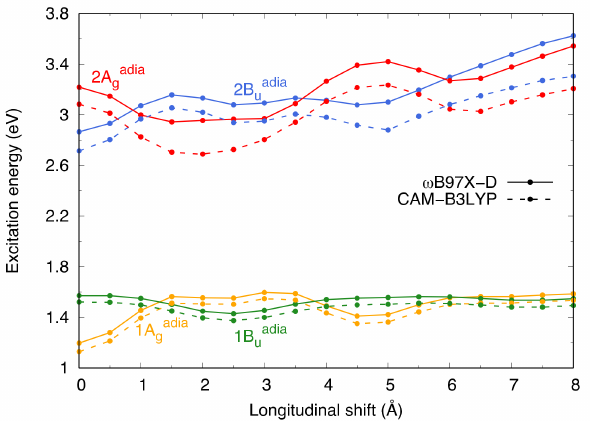
Figure 7. Comparison between excitation energies of triplet exciton states of PDI dimer computed with TDA-CAM-B3LYP/6-31G* (dashed) and TDA- ω B97X-D/6-31G* (solid) along the longitudinal shift.